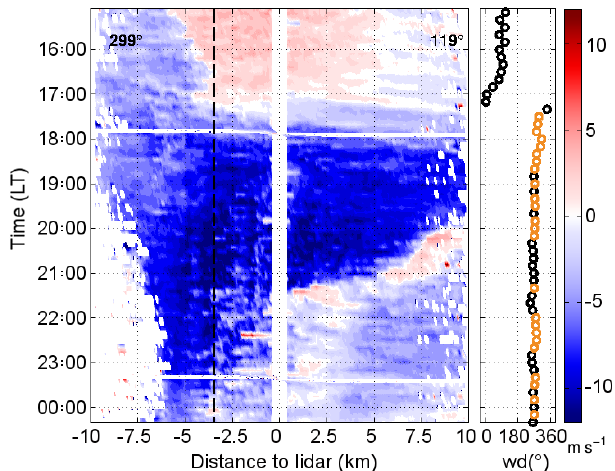
Figure 6. Example for a mixed event on 28 August 2014. Hov- moeller diagram of the near-surface radial velocity from lidar RHI scans at an azimuth angle of 299 and 7 ◦ elevation west of the li- dar and 1.6 ◦ east of the lidar. The black dashed line indicates the end of the western slope and the beginning of the valley floor. Wind direction (wd) was measured in 40ma.g.l. Orange points highlight wind directions between 270 and 330 ◦ , the main wind direction of the